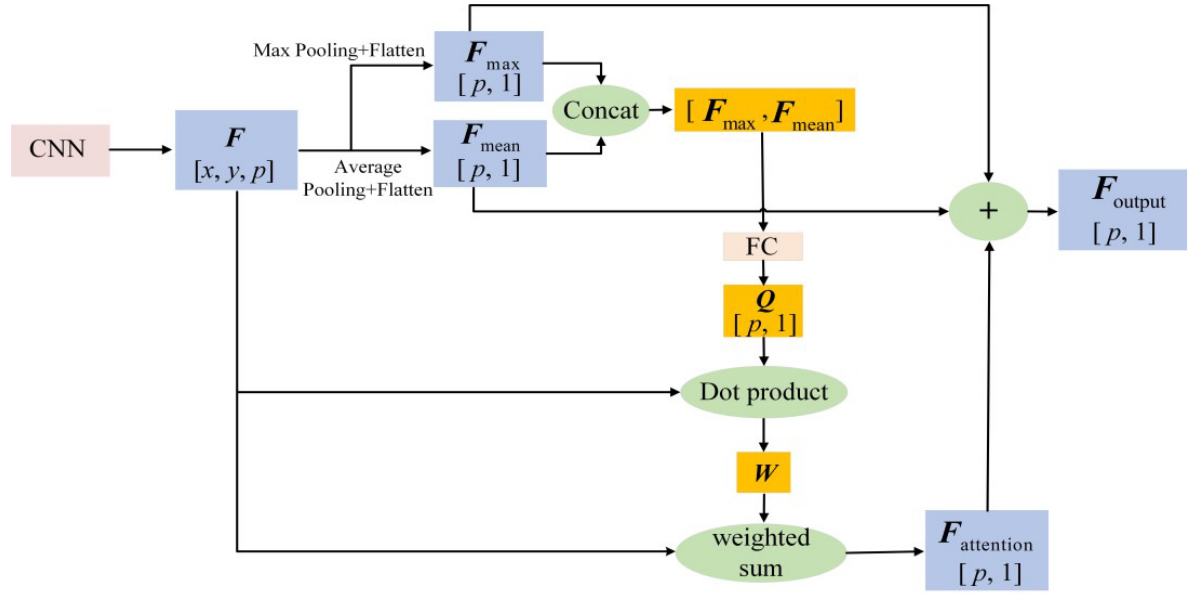
Figure 3. Flowchart of the attention mechanism.